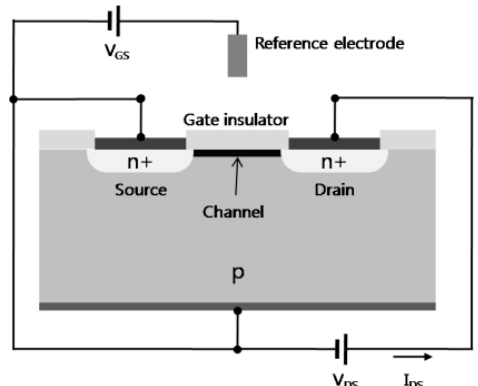
Figure 9. Structure of an ion-sensitive field-effect transistor (ISFET): source, drain, gate insulator, reference electrode, electrolyte in-between the reference, and the gate insulator. Reproduced from Lee et al. [70], under Creative Commons Attribution License (CC BY 3.0).